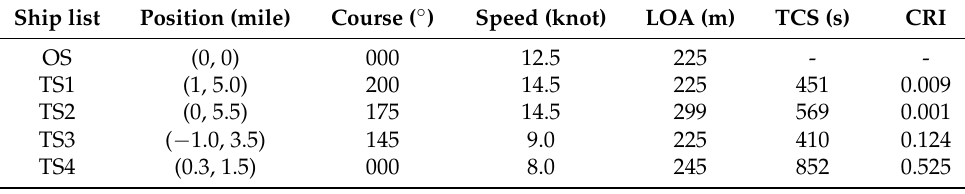
Table 4. Initial information of the ships for simulation in scenario 2.